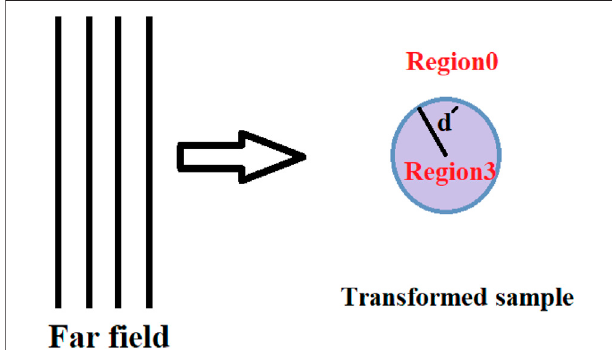
FIGURE5 | Schematic plan for bare transformed cylinder with radius d ′ . ε ′ (cid:2) ε μ ′ (cid:2) μ sample c / a and sample c / a are the CP of the bare transformed object that illuminated by planewave.